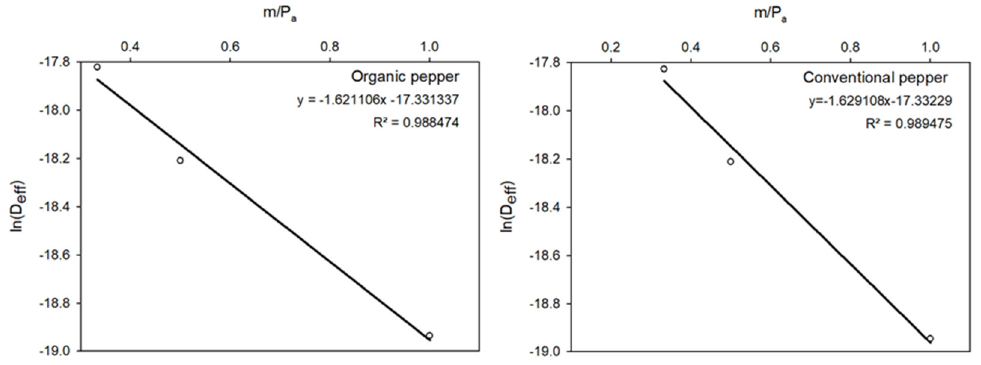
Figure 5. Arrhenius plot for the calculation of the activation energy of organic and conventional red peppers.